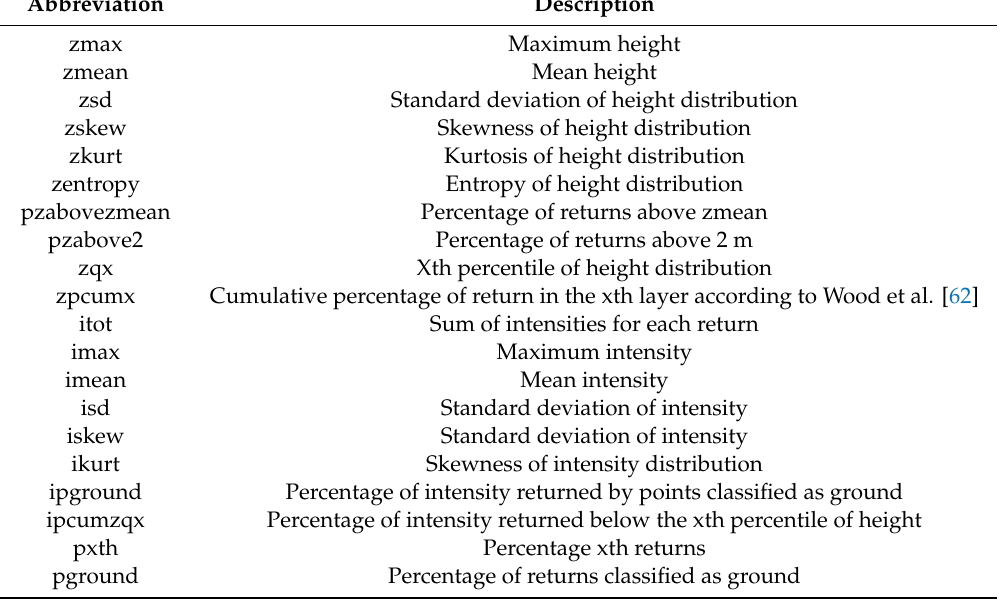
Table 1. Light Detection and Ranging (LiDAR) metrics used to estimate sapling density of all species and commercial